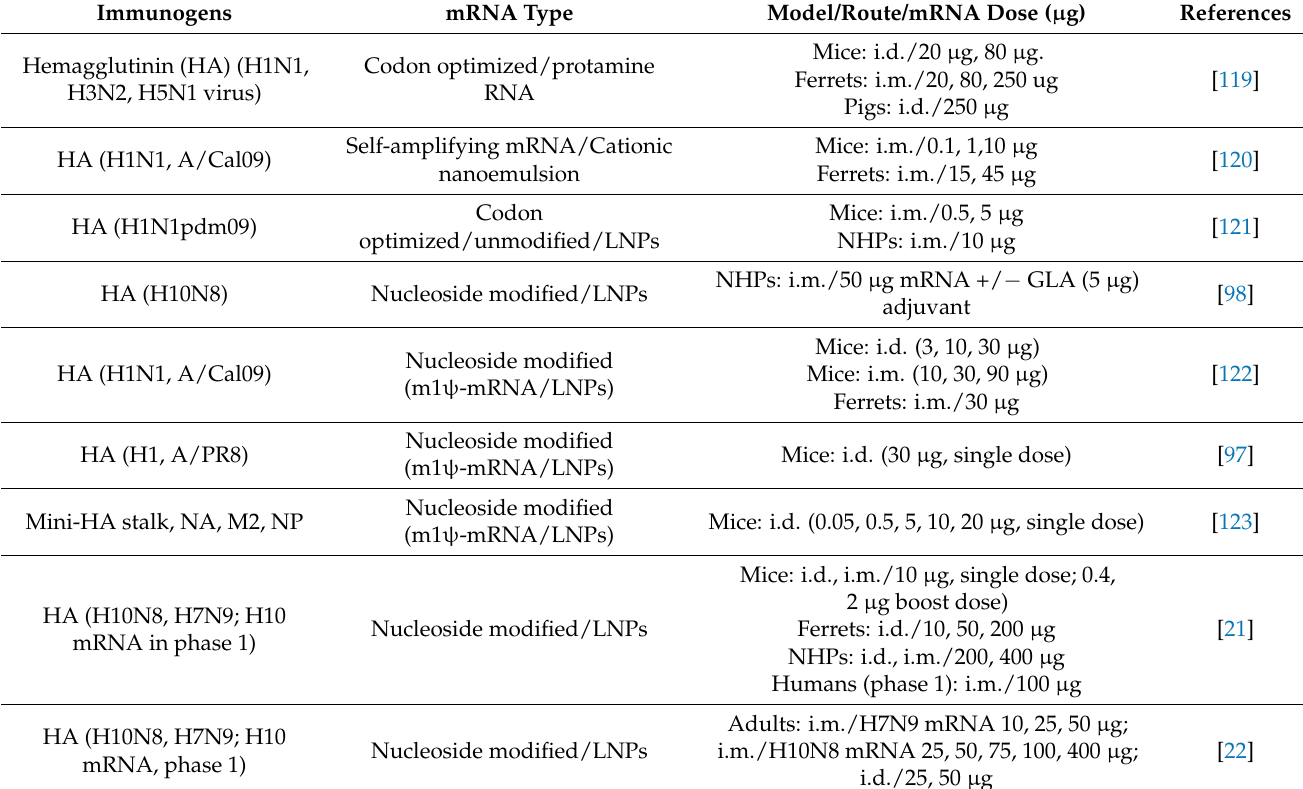
Table 2. mRNA-based influenza